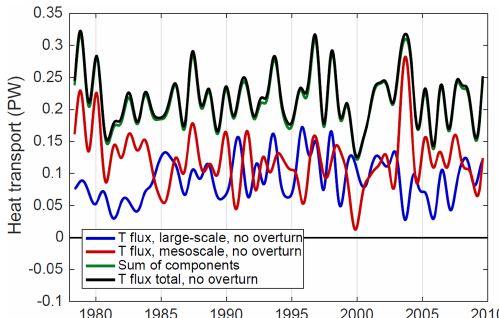
Figure 5. Basin-integrated contributions of large-scale and mesoscale v and T to the ID variability of heat transport across 40 ◦ N in the Atlantic. The zonal means of v and T are removed prior to the computations. The sum of the large-scale and mesoscale com- ponents (green) is compared to the total temperature flux minus the overturning contribution (black); differences between the two are due to high-frequency covariances of v and T at timescales shorter than